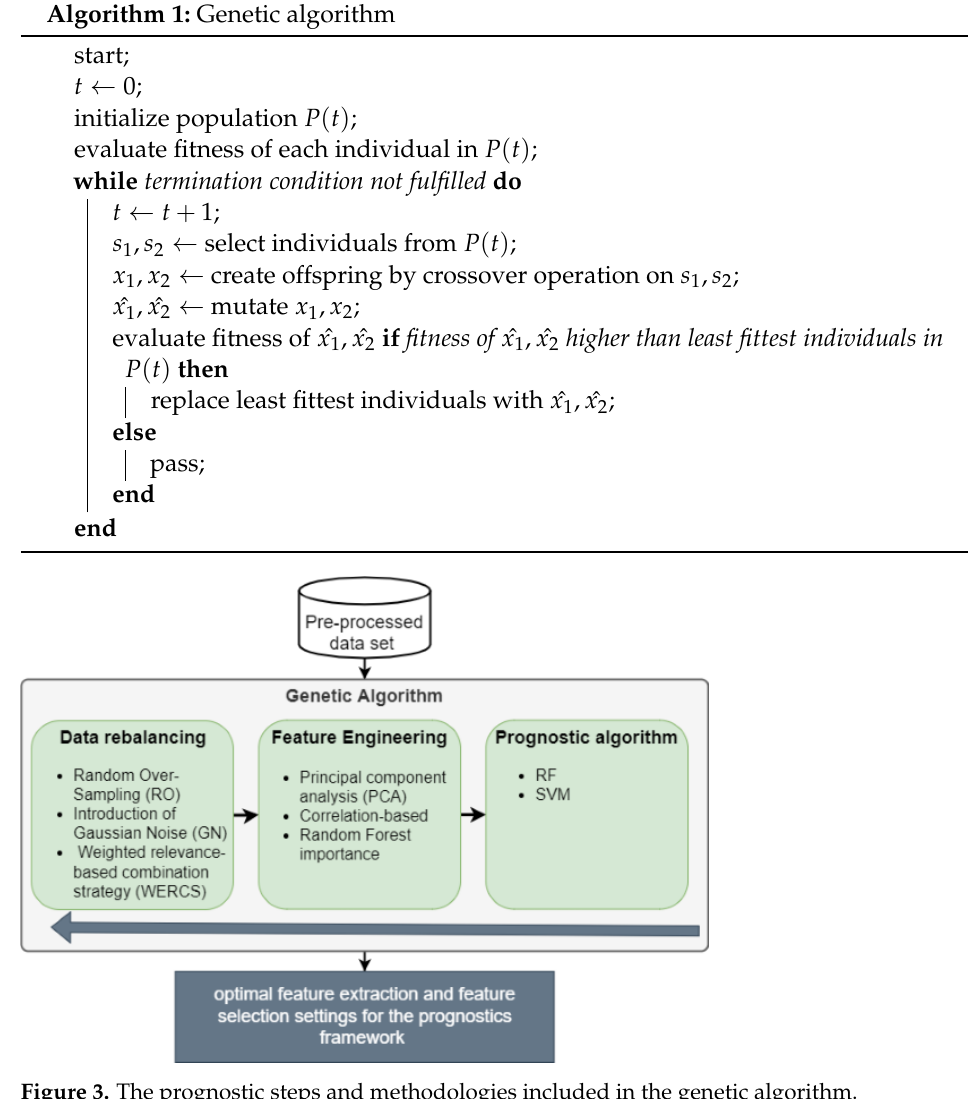
Algorithm 1: Genetic algorithm